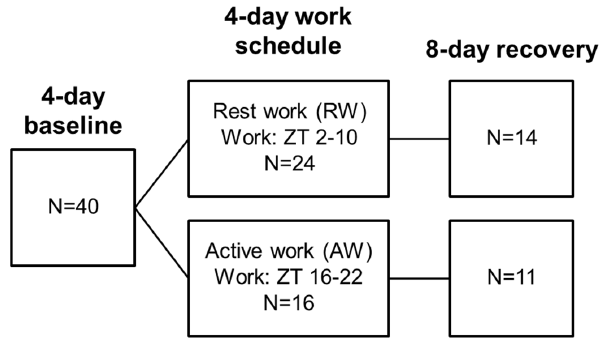
Figure 1. Overview of the study design. Animals were monitored for four baseline days, and a four